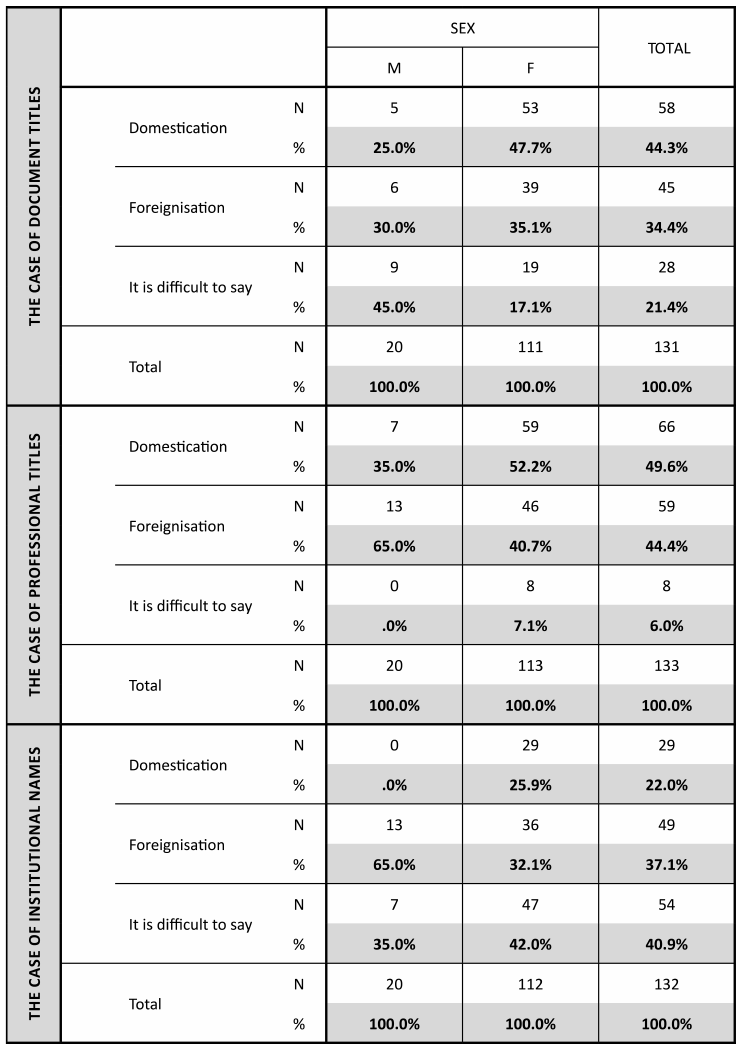
Cross tabulation between strategy and gender of the